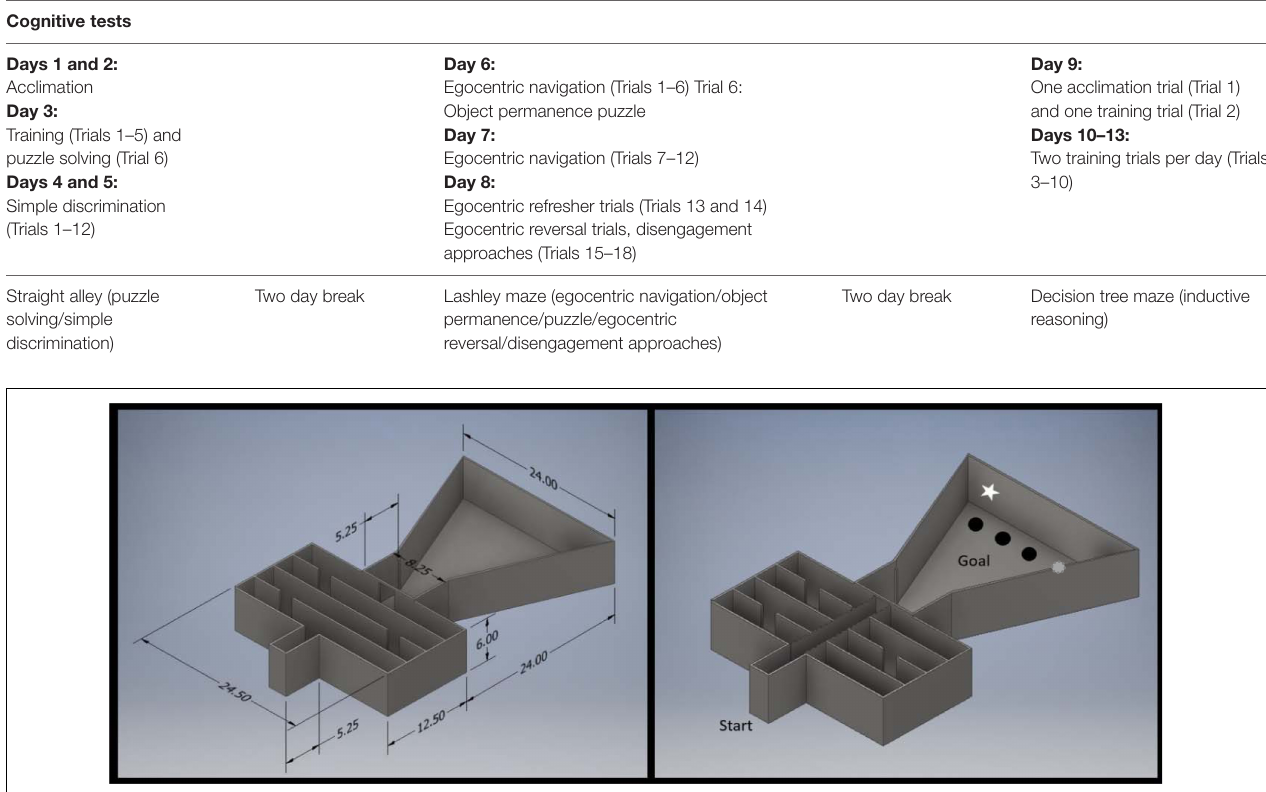
FIGURE 1 | The straight alley and Lashley maze configurations of a single test chamber. The left panel illustrates the maze configuration, and the right illustrates the straight alley configuration. The start box is located near the left side of the maze, and the goal location is near the right. Depending on the task, either 1, 2, or 4 food cups were present at the goal location. In some tasks, discriminative cues were mounted on the wall behind the goal cups (illustrated by the star over Position 1). The apparatus was constructed of black Plexiglas and measurements are in cm.